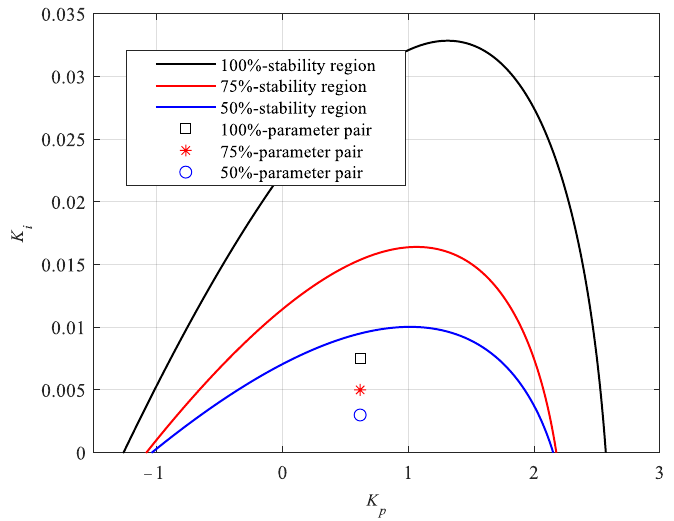
Figure 4. Stability region and parameter distribution of PID parameters under different operating conditions.